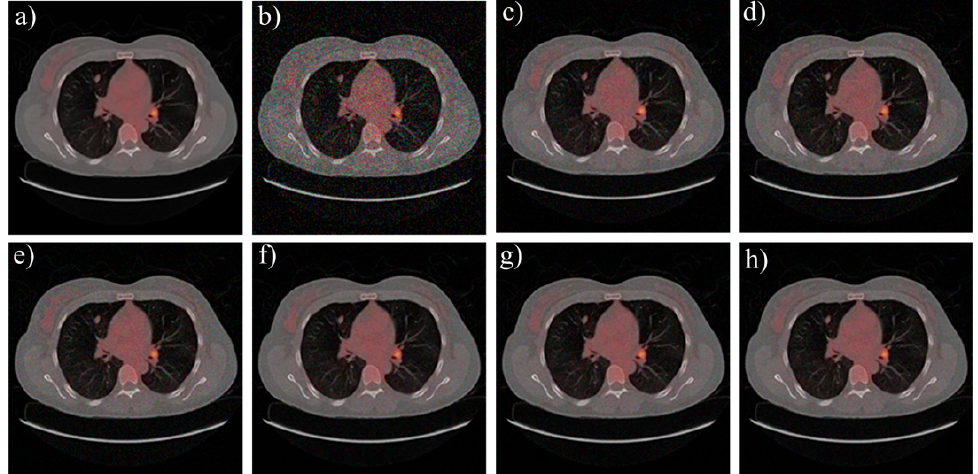
Figure 3. Denoising performance of the six algorithms to the CT image. ( a ) Original image; ( b ) noisy image; ( c ) MP; ( d ) OMP; ( e ) BP; ( f ) FAL0; ( g ) AL0; ( h ) AL0-L.